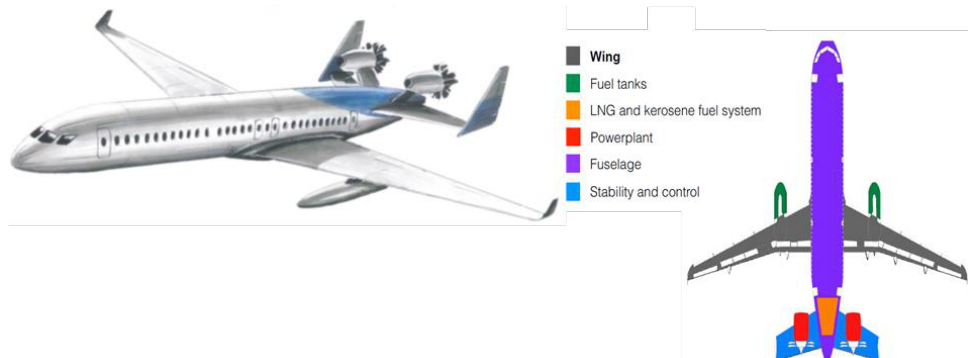
Figure 27. A multi-fuel A320 class of aircraft with podded LNG tanks and open rotors designed by students at Delft University of Technology (TU Delft).